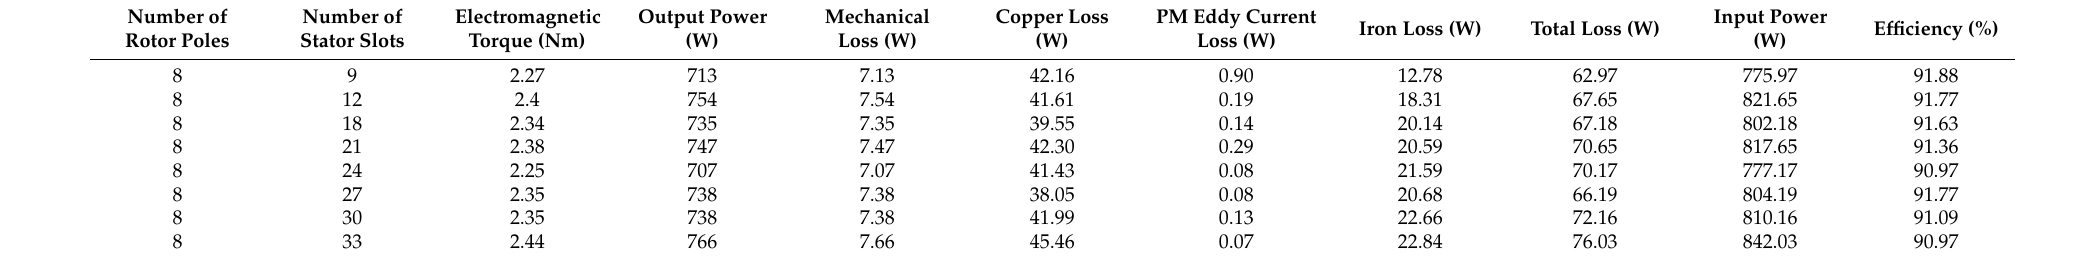
Table 9. Various losses and efficiency when the number of rotor poles is 8 and the number of stator slots takes different values. Number of Rotor Poles